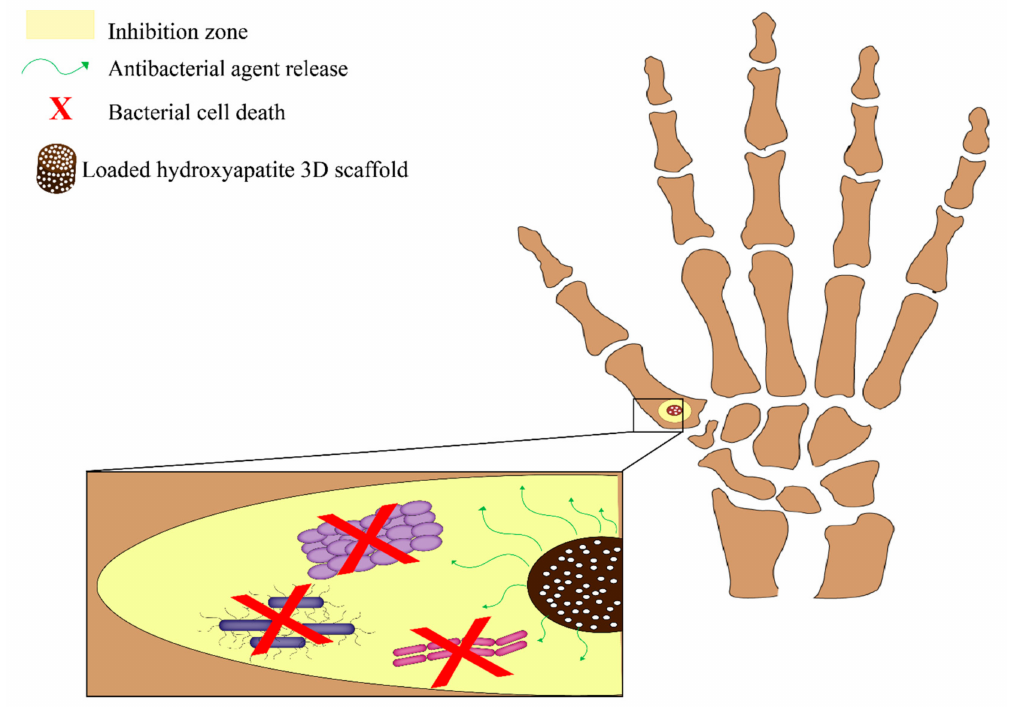
Figure 6. Schematic representation of the loaded hydroxyapatite/SSG 3D scaffold as a promising biomaterial for orthopedic